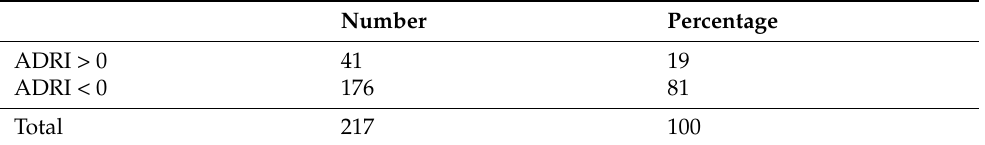
Table 5. Agricultural drought resilience index (ADRI) of Northern Cape Province of South